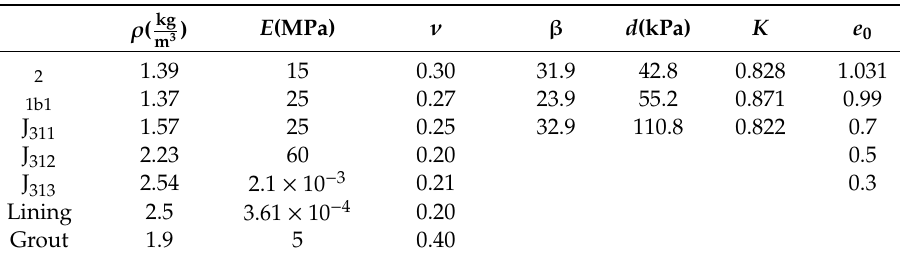
Table 1. Material parameters of FEA model